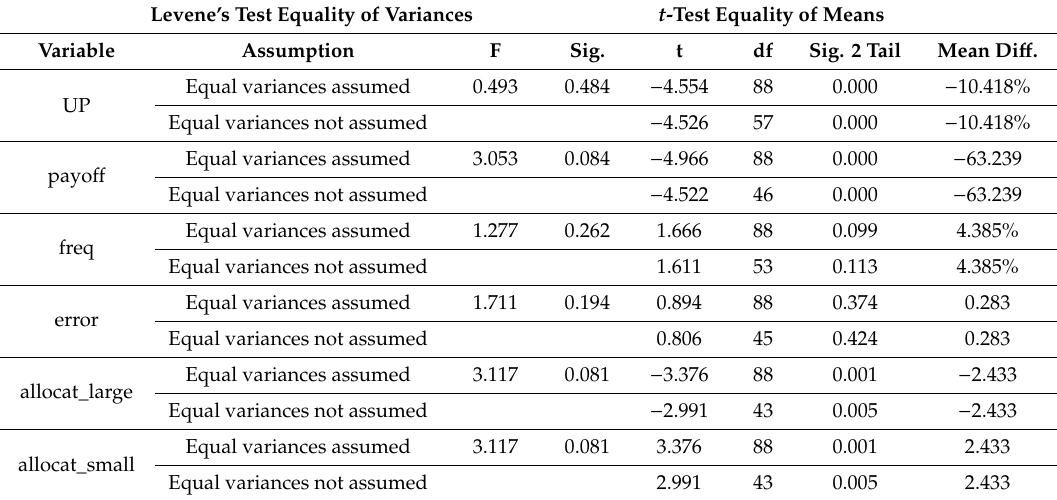
Table 5. Levene’s test for the equality of variances and the t -test for the equality of the means of the outcomes of the auction with and without a